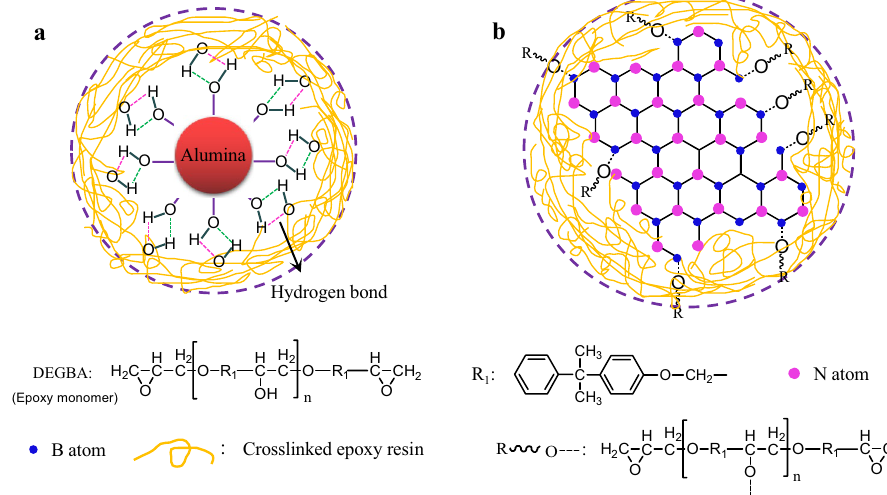
Figure 7. Interfacial structures of fillers with epoxy molecular ( a ) alumina, and ( b ) BNNs.